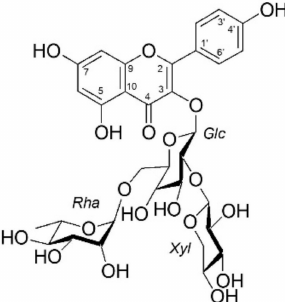
Figure 1. The chemical structure of KXRG isolated from C. brevistyla seeds. Nuclear magnetic res- onance ( 1 H NMR and 13 C NMR) techniques were used for the structural determination of KXRG. NMR spectra were recorded on a Varian spectrometer (400 MHz for 1 H NMR and 100 MHz for 13 C NMR) in CD 3 OD.